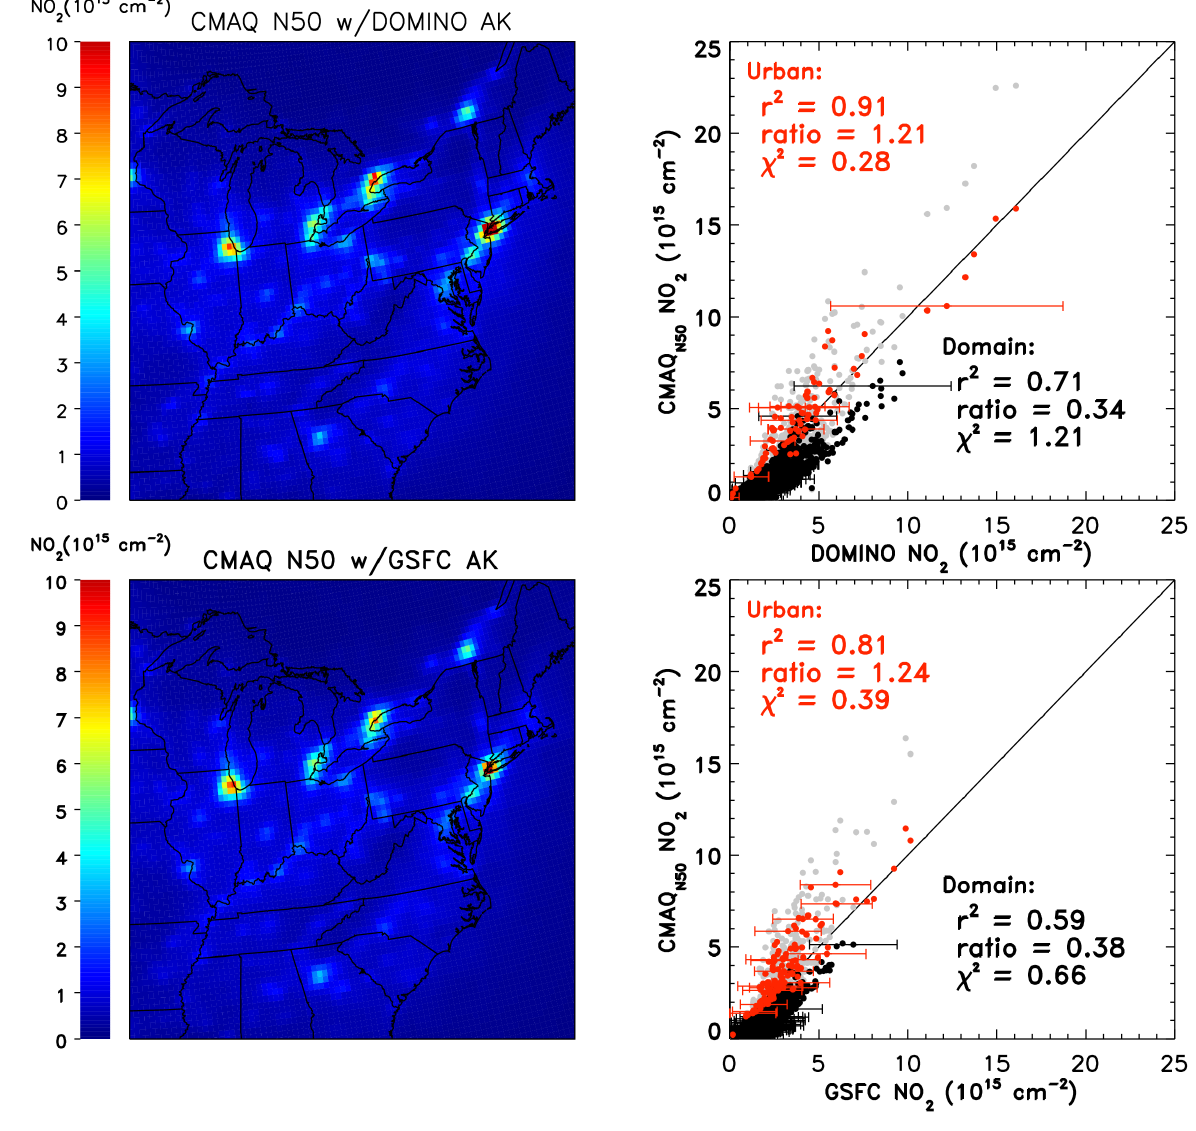
Figure 6. Same as Fig. 2 except model results include both changes to NTR chemistry and a 50% reduction in the emissions of NO x from mobile sources (CMAQ N50 ). Gray points on the scatter plots represent the results shown in Fig. 2 (right